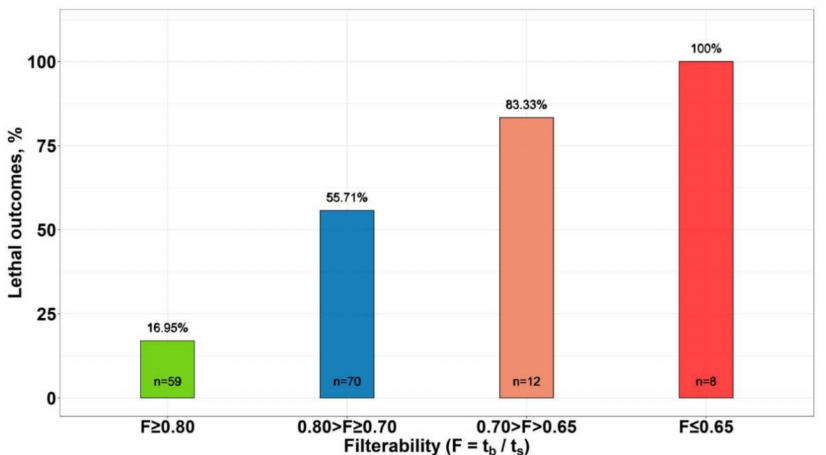
Figure 4. The percentage of deaths in groups of patients with different filterability of erythrocytes (F). The filterability levels in the groups were equal to: F ≥ 0.80; 0.80 > F ≥ 0.70; 0.70 > F > 0.65 and F ≤ 0.65. The figure shows the number of patients and the percentage of mortality in each group. Existence of a statistically significant relationship between filterability groups and mortality was proved by Fisher’s exact test with Monte Carlo simulation ( p =